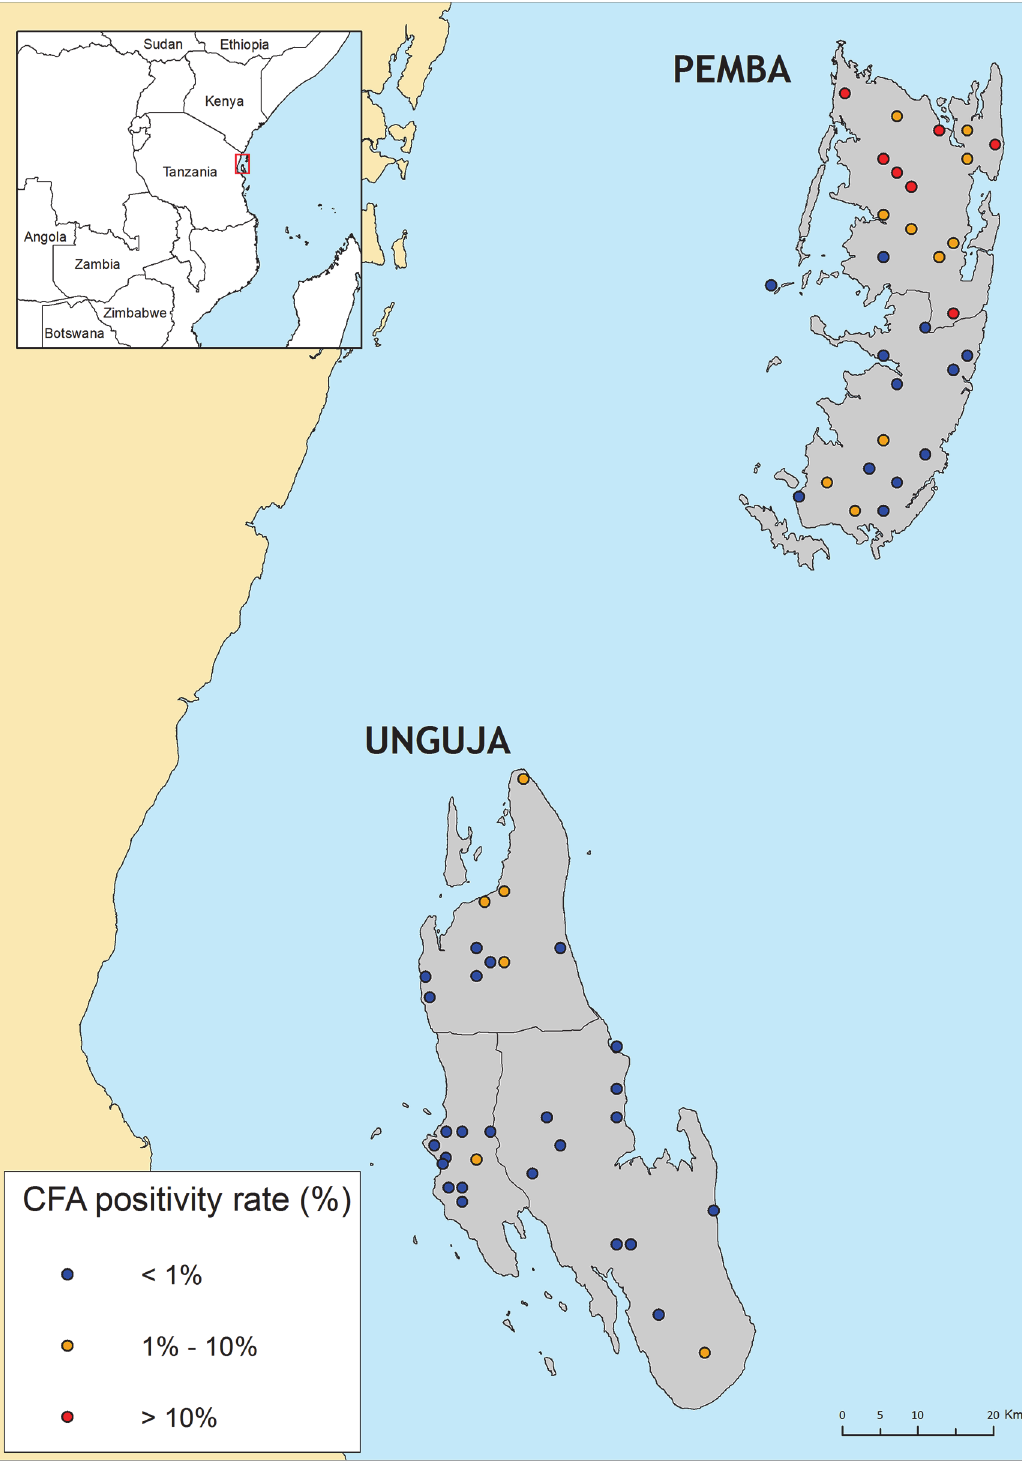
Fig 1. Spatial distribution and antigen positivity rates of schools selected for TAS surveys on Pemba and Unguja islands in Zanzibar, United Republic of Tanzania.